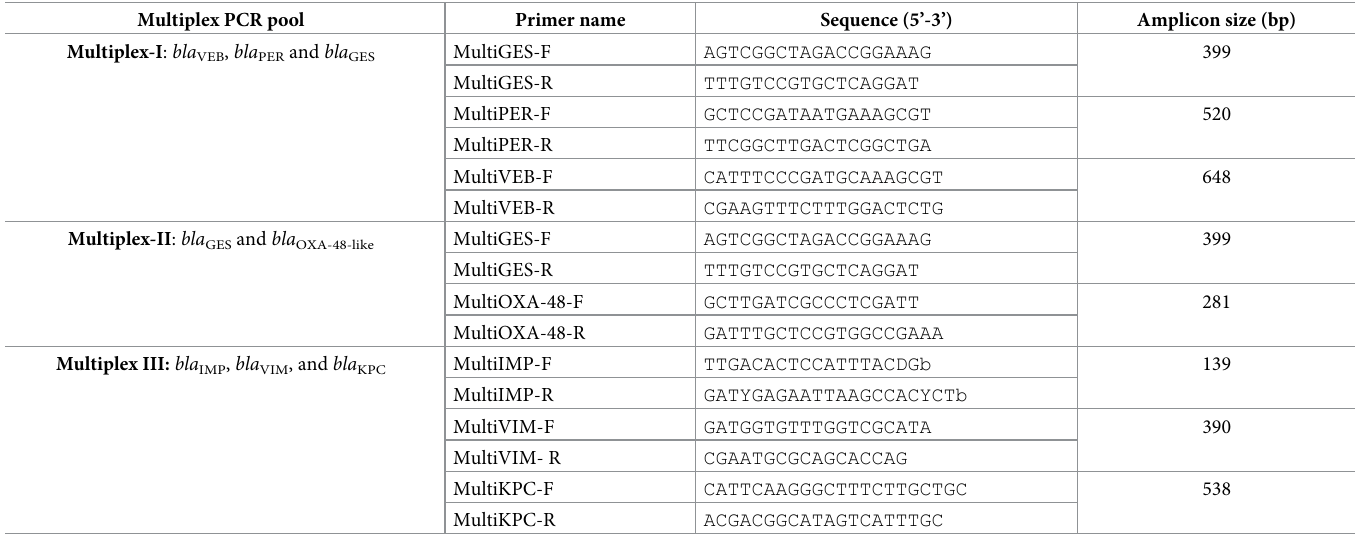
Table 3. Primers’ sequence of carbapenemase genes [31].